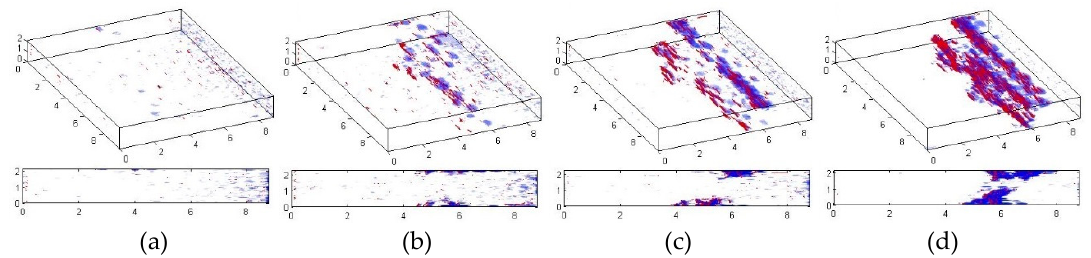
Figure 15. Results of destructive tensile tests for various self-heating temperature values.